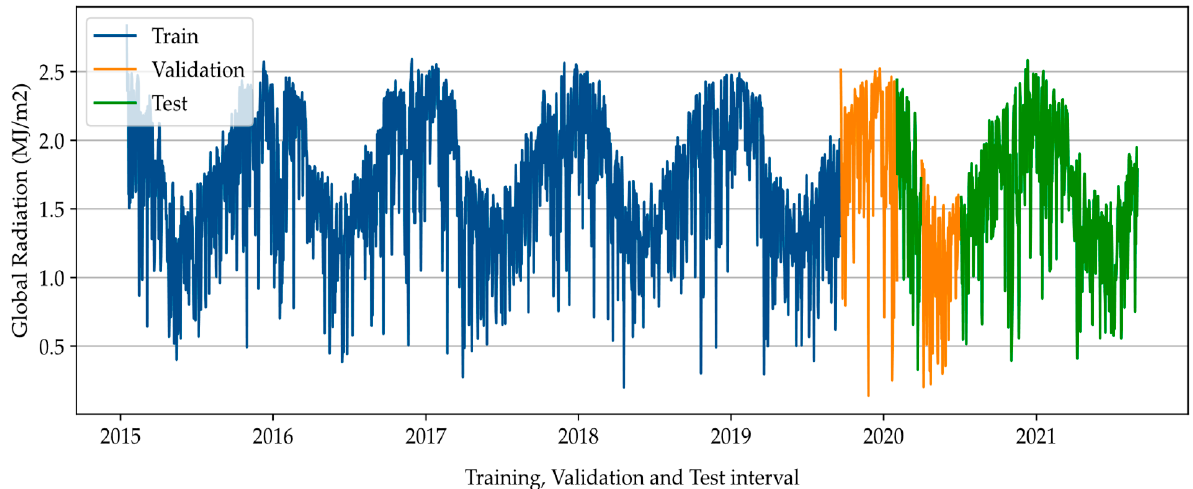
Figure 3. Training, validation and testing set of solar radiation historical series.